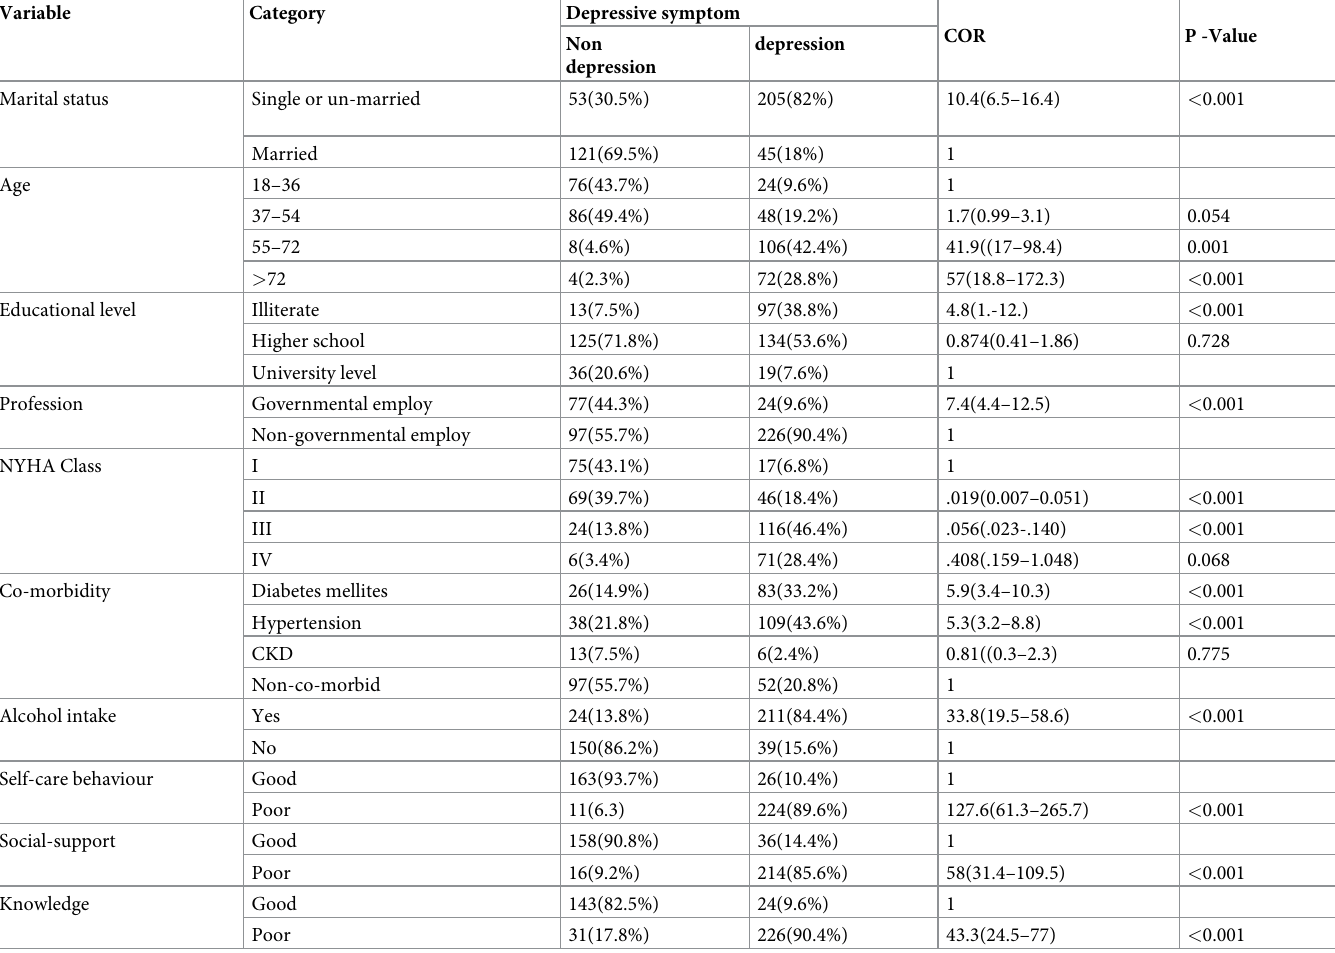
Table 2. Factor associated with depression in bi-variate logistic regression among heart failure patients attending cardiac follow-up clinic at selected government hospitals (n =